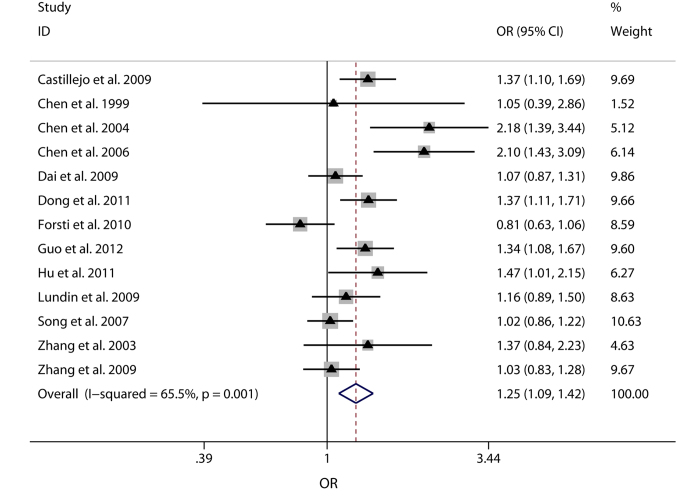
Forest plots of OR with 95% CI for Int7G24A rs334354 polymorphism and cancer
risk applying allele model (A vs. G).The triangles and horizontal lines correspond to the study-specific ORs and
95% CIs. The gray areas reflect the study-specific weight. The hollow
diamonds represent the pooled OR and 95% CI of the overall population. The
vertical solid lines show the OR of 1 and the vertical dashed lines indicate
the corresponding pooled ORs.